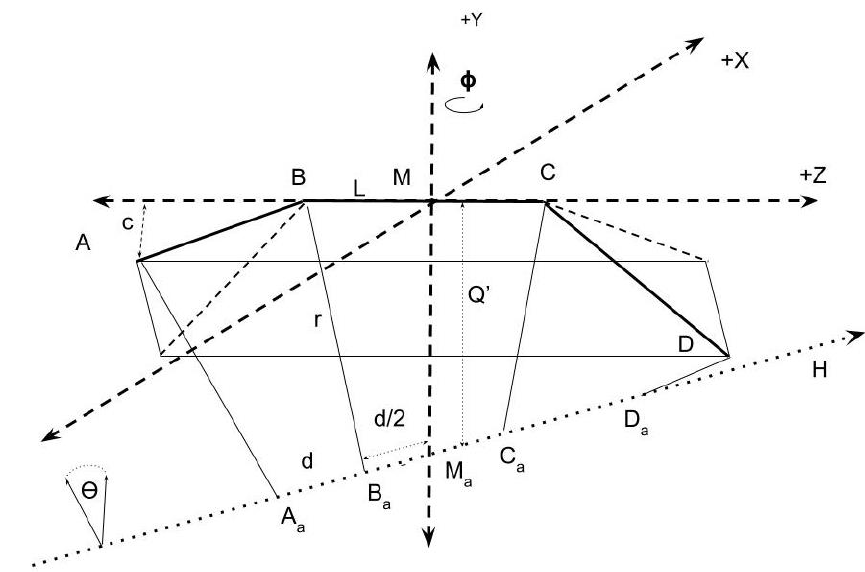
Figure 5. Three Symmetric